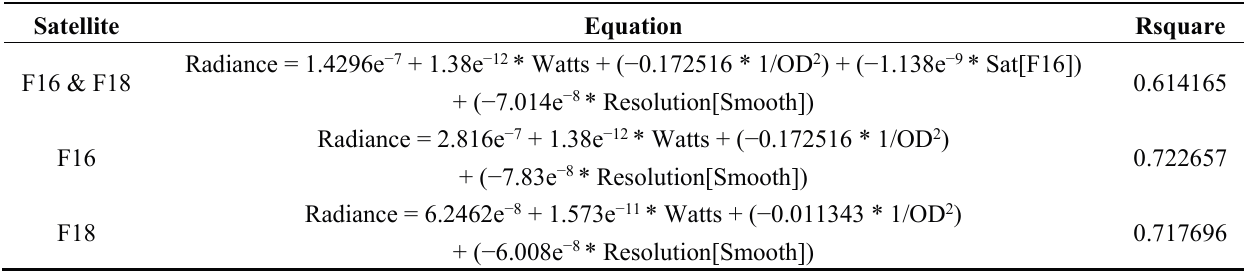
Table 1. Results of Linear Regression